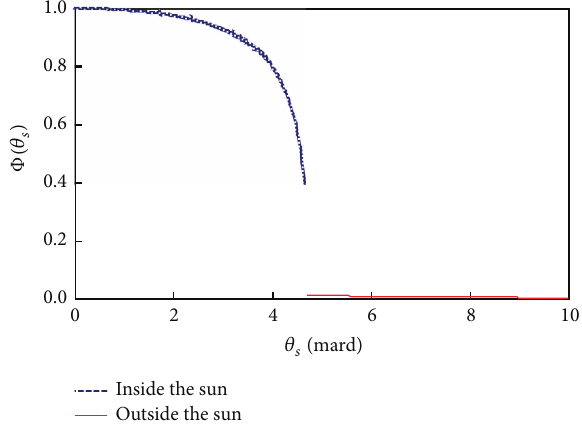
Figure 2: The calculated result of Buie model.